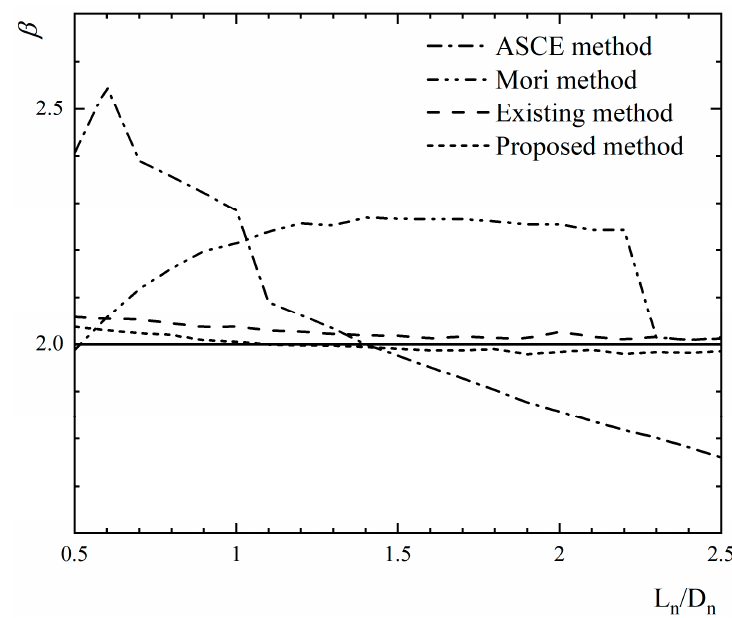
Figure 6. Reliability calculated by different methods for L n / D n = 0.5–2.5 ( β T = 2).